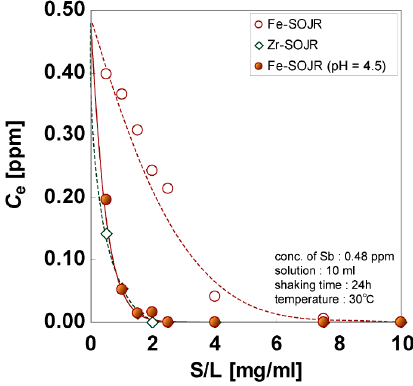
Figure 29. Effect of solid/liquid ratio (= dry weight adsorbent added/ volume of solution) on the residual Sb concentration when metal-loaded SOJR gels were used to remove Sb from a real waste solution (pH = 10.5) generated in a polyester fiber production factory.